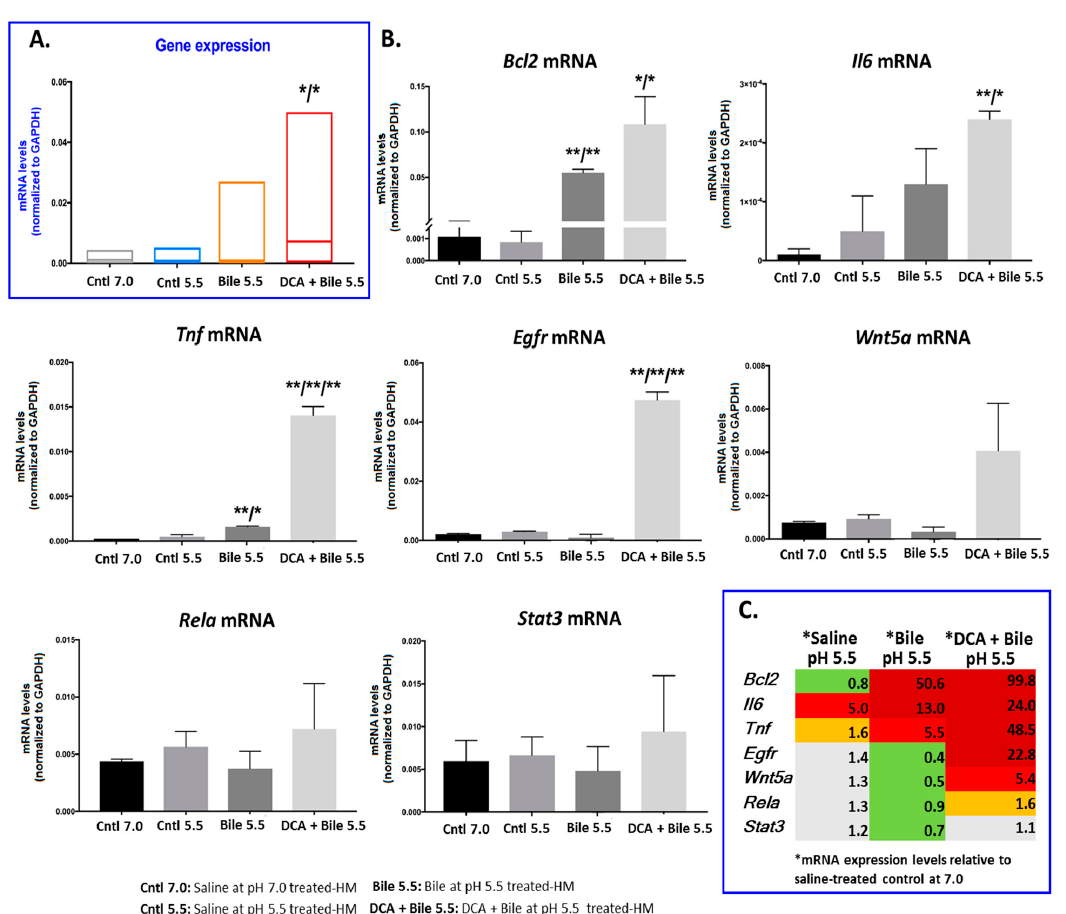
Figure 4. Weakly acidic bile-induced transcriptional activation of NF- κ B-related oncogenic phenotype in murine hypopharyngeal mucosa (HM) after 15 weeks of exposure. ( A ) Graph depicts mRNA levels of all analyzed NF- κ B-related genes ( Bcl2 , Il6 , Tnf , Egfr , Wnt5a , Rela , and Stat3 ) after exposure to bile at pH 5.5 with or without DCA vs. controls ( p value using one-way ANOVA, Friedman test; Graph Pad Prism software 7.0). ( B ) Graphs indicate transcriptional levels of each analyzed gene in HM exposed to weakly acidic bile vs. controls (* p < 0.01; ** p < 0.001; t -test; multiple comparisons using Holm-Sidak; GraphPad Prism 7.0). ( C ) Table shows the changes of the mRNA oncogenic phenotype (fold-change of mRNAs) caused by bile with or without DCA at weakly acidic pH 5.5 vs. control (saline at pH 7.0). (By real-time qPCR analysis; data obtained from four analyzed samples).